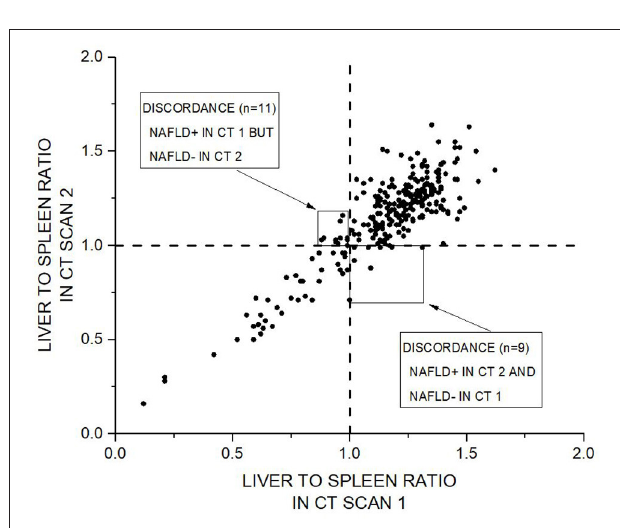
FIGURE 4 | Scatter plot of liver to spleen ratio (L/S) in CT scan 1 vs. CT scan 2 demonstrating concordance for L/S based classification in repeated low dose computed tomography scans. Dashed vertical and horizontal lines represent L/S cut of value of 1, which is used in division of study population to subjects with non-alcoholic fatty liver disease (NAFLD + ) and subjects without non-alcoholic fatty liver disease (NAFLD–). Totally 241 cases (92%) were classified concordantly in the CT scan 1 and CT scan 2. Twenty of cases (8%) were discordantly classified into NAFLD– or NAFLD +